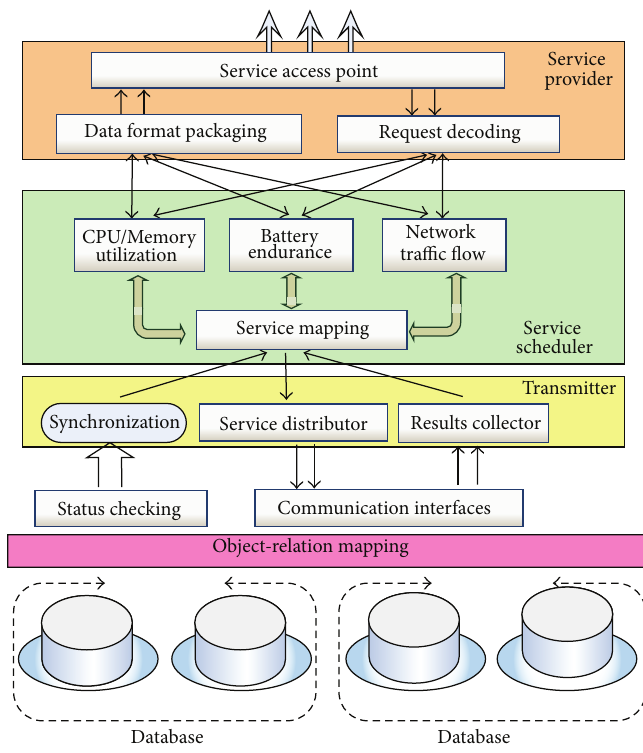
Figure 3: Hierarchical layer of